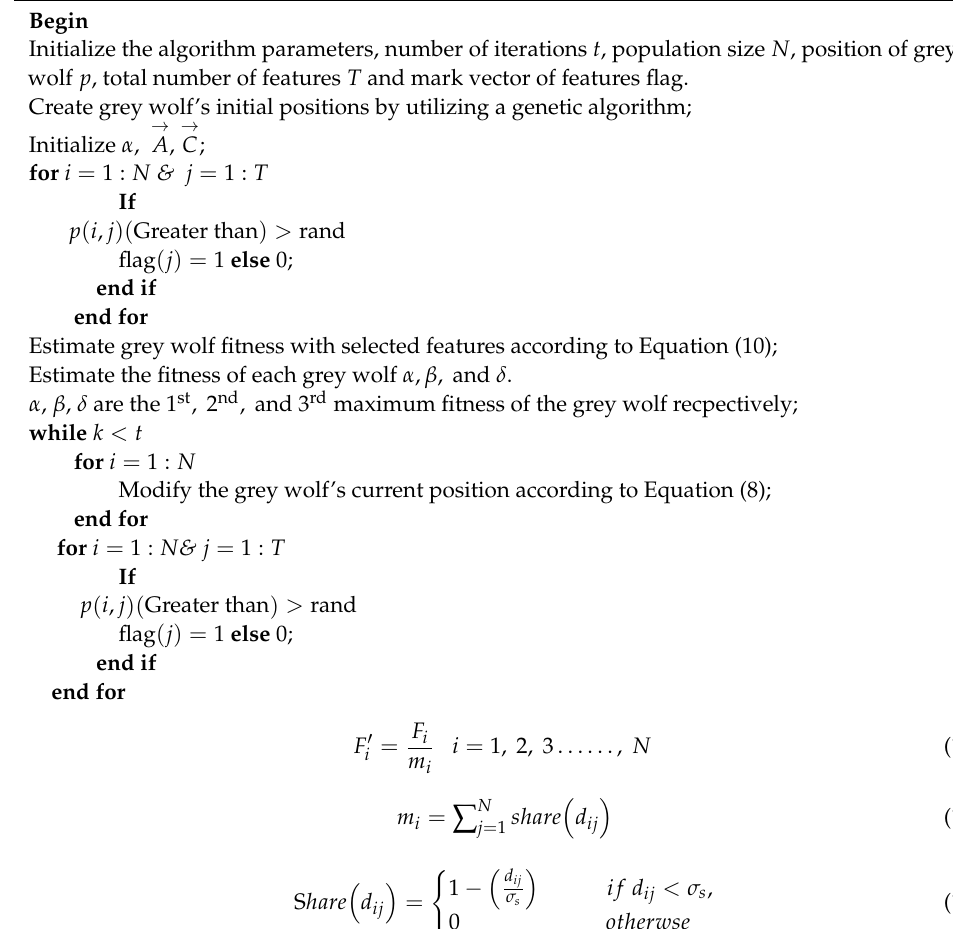
Algorithm 2. The pseudocode of the IGWO.